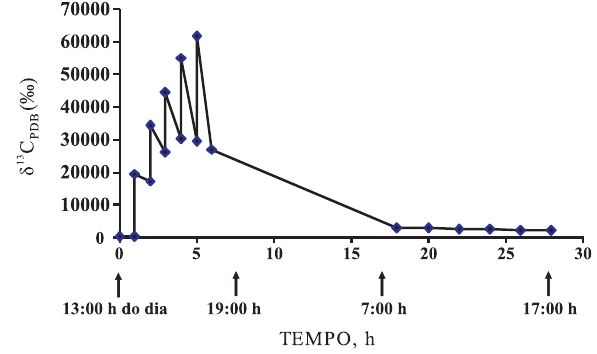
Figura 3. Evolução da composição isotópica do CO ( δδδδδ 13 C ) na câmara ao longo do tempo de PDB marcação. As setas pretas mostram a hora do dia ao longo do processo de